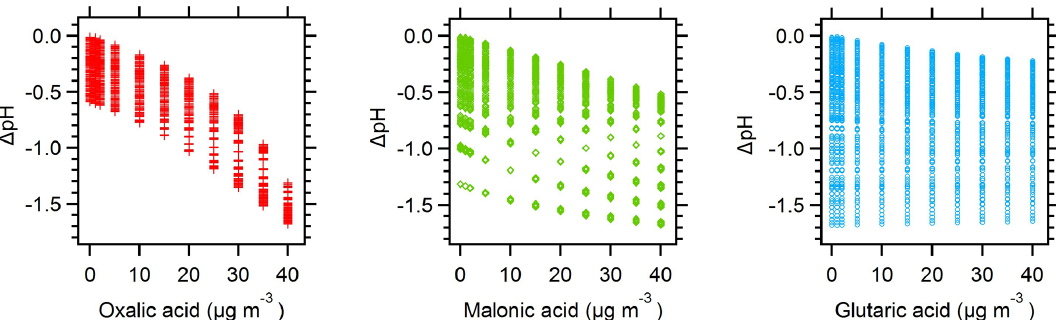
Figure 6. (cid:49) pH vs. discrete organic acid levels for the organic acid pH calculations carried out in E-AIM for Baltimore and Beijing. (cid:49) pH represents the difference between the initial inorganic-only pH prediction and all other model evaluations where organic acids were